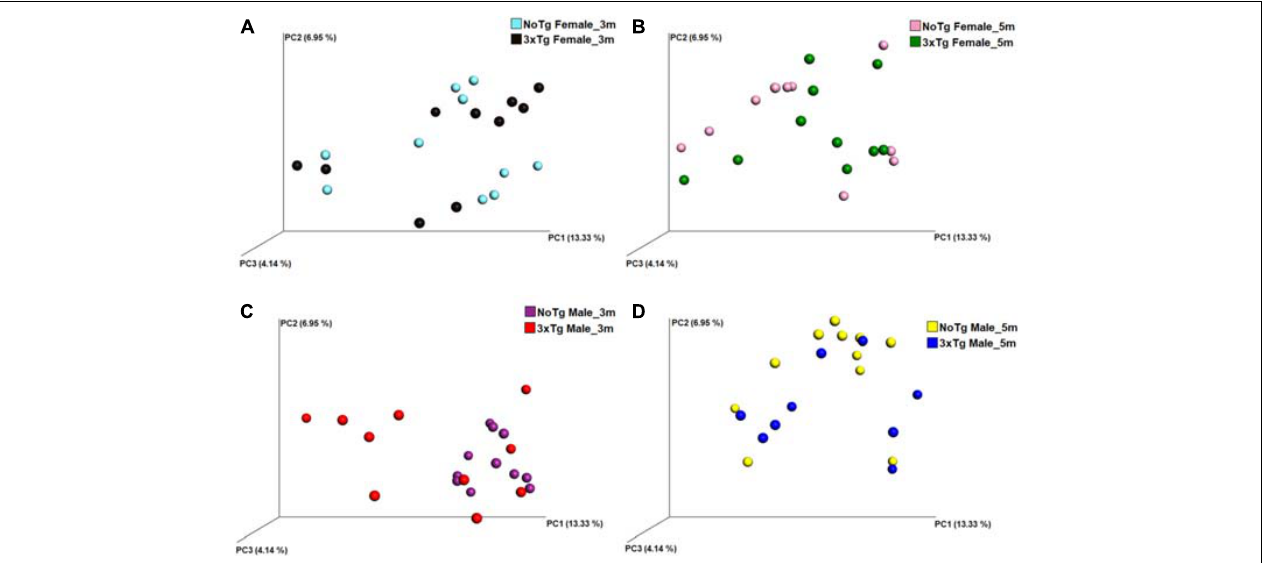
FIGURE 8 | Beta diversity of bacteria in fecal samples collected from non-transgenic (NoTg) and Alzheimer’s disease triple-transgenic (3xTg-AD) mice. The graphics show beta diversity analyses calculated by dissimilarity metrics using operational taxonomic unit (OTU) tables and Unweighted UniFrac analyses. The analyses show the dissimilarity among mice by colors: NoTg female at 3 months (m) old (cyan), 3xTg-AD female at 3 months old (black), NoTg female at 5 months old (pink), 3xTg-AD female at 5 months old (green), NoTg male at 3 months old (purple), 3xTg-AD male at 3 months old (red), NoTg male at 5 months old (yellow), 3xTg-AD male at 3 months old (blue). Data comparisons by genotype and sex: NoTg vs. 3xTg-AD female mice at 3 months old (A) , NoTg vs. 3xTg-AD female mice at 5 months old (B) , NoTg vs. 3xTg-AD male mice at 3 months old (C) , and NoTg vs. 3xTg-AD male mice at 5 months old (D) . The three-dimensional scatter plots were generated using principal coordinates analyses (PCoA) in three different axis that show the percentage of total differences. There were significant differences on all comparisons according to ANOSIM similarity test ( (A) , R = 0.184, p = 0.018; (B) , R = 0.124, p = 0.028; (C) , R = 0.422, p = 0.001; (D) , R = 0.174, p = 0.022).